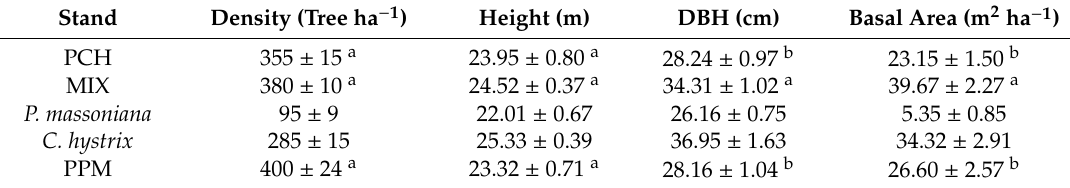
Table 1. Characteristics of pure Castanopsis hystrix Miq. (PCH) plantation, pure Pinus massoniana Lamb. (PPM) plantation, and mixed C. hystrix and P. massoniana (MIX) plantation (mean ± standard error; n =